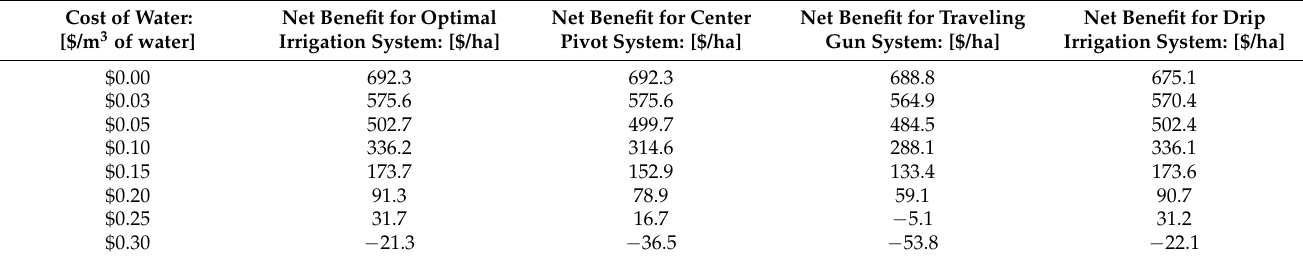
Table A4. Net benefit values associated with corn production for each irrigation system under various water cost values. Cost of Water: [$/m 3 of water]